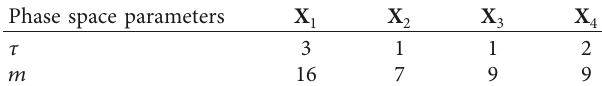
Figure 1: Vibration time series X of a superprecision rolling bearing. Table 1: Phase space parameters of 4 subseries.